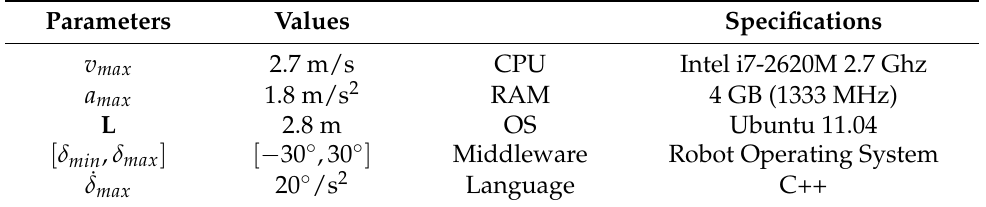
Table 2. The simulation conditions.